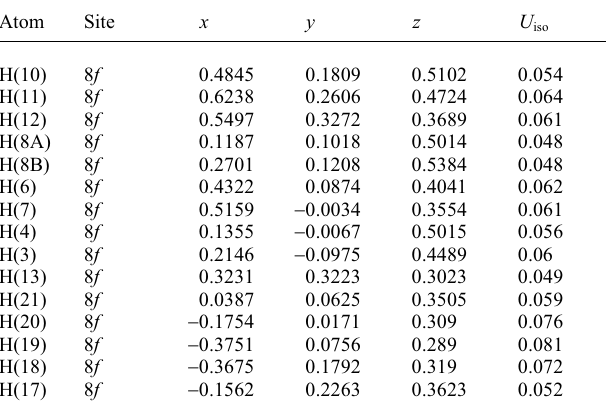
Table 2. Atomic coordinates and displacement parameters (in Å 2 )